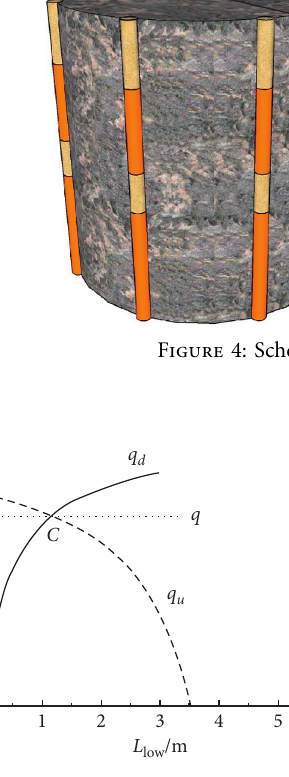
− L d , q d d , and q u